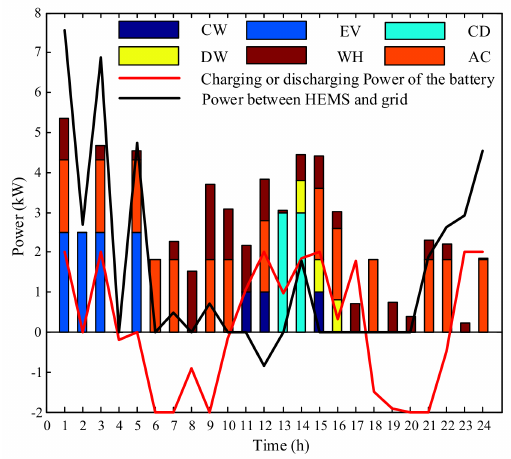
Figure 6. The complete robust schedules of household appliances.